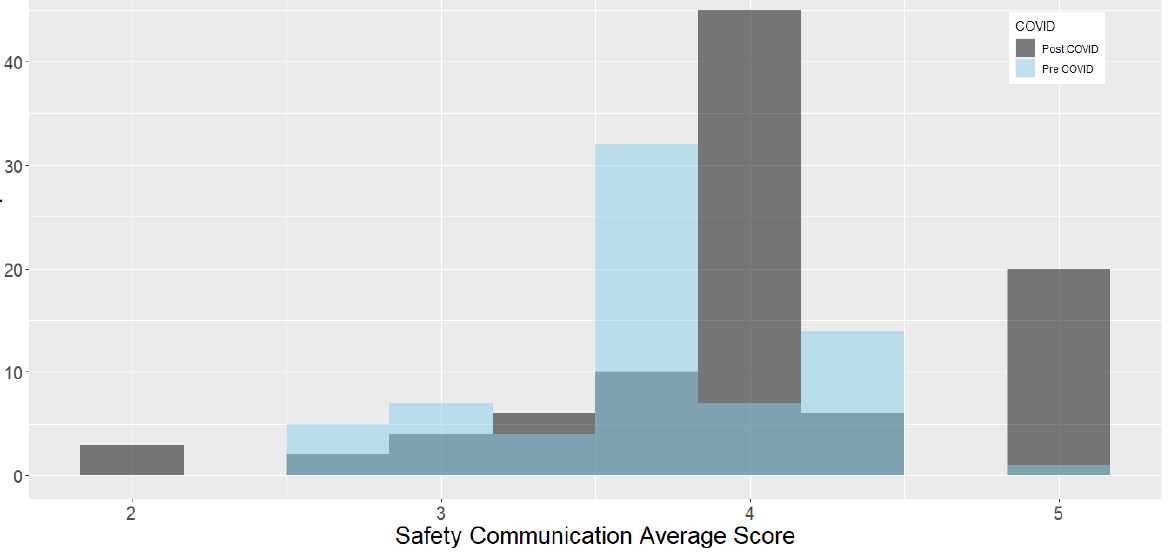
Table 4. Safety Climate Survey Likert Scale & Organization Elements ANOVA Results. Factor: COVID-19 (df 1:154)